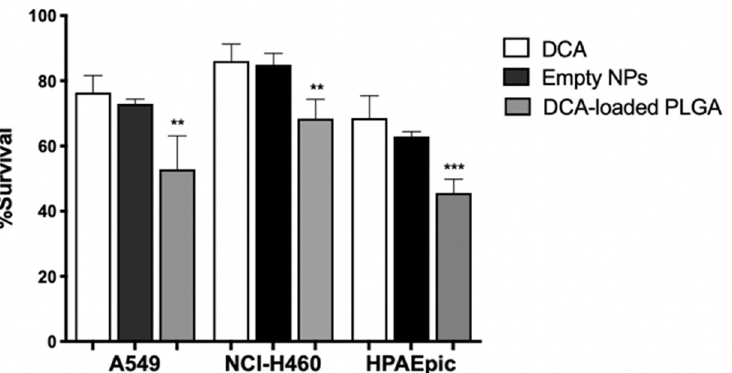
Figure 7. Effect of DCA, DCA-loaded PLGA NPs and empty NPs on cell viability of A549, NCI-H460 and HPAEpic cells. SRB assay of A549, NCI-H460 and HPAEpic cells treated with 125 µ g/mL of DCA, DCA-loaded PLGA NPs, or empty NPs at 24 h. Results are expressed as means ± SD of triplicates from at least three independent experiments. ** p < 0.01; *** p < 0.001 compared to DCA (control).